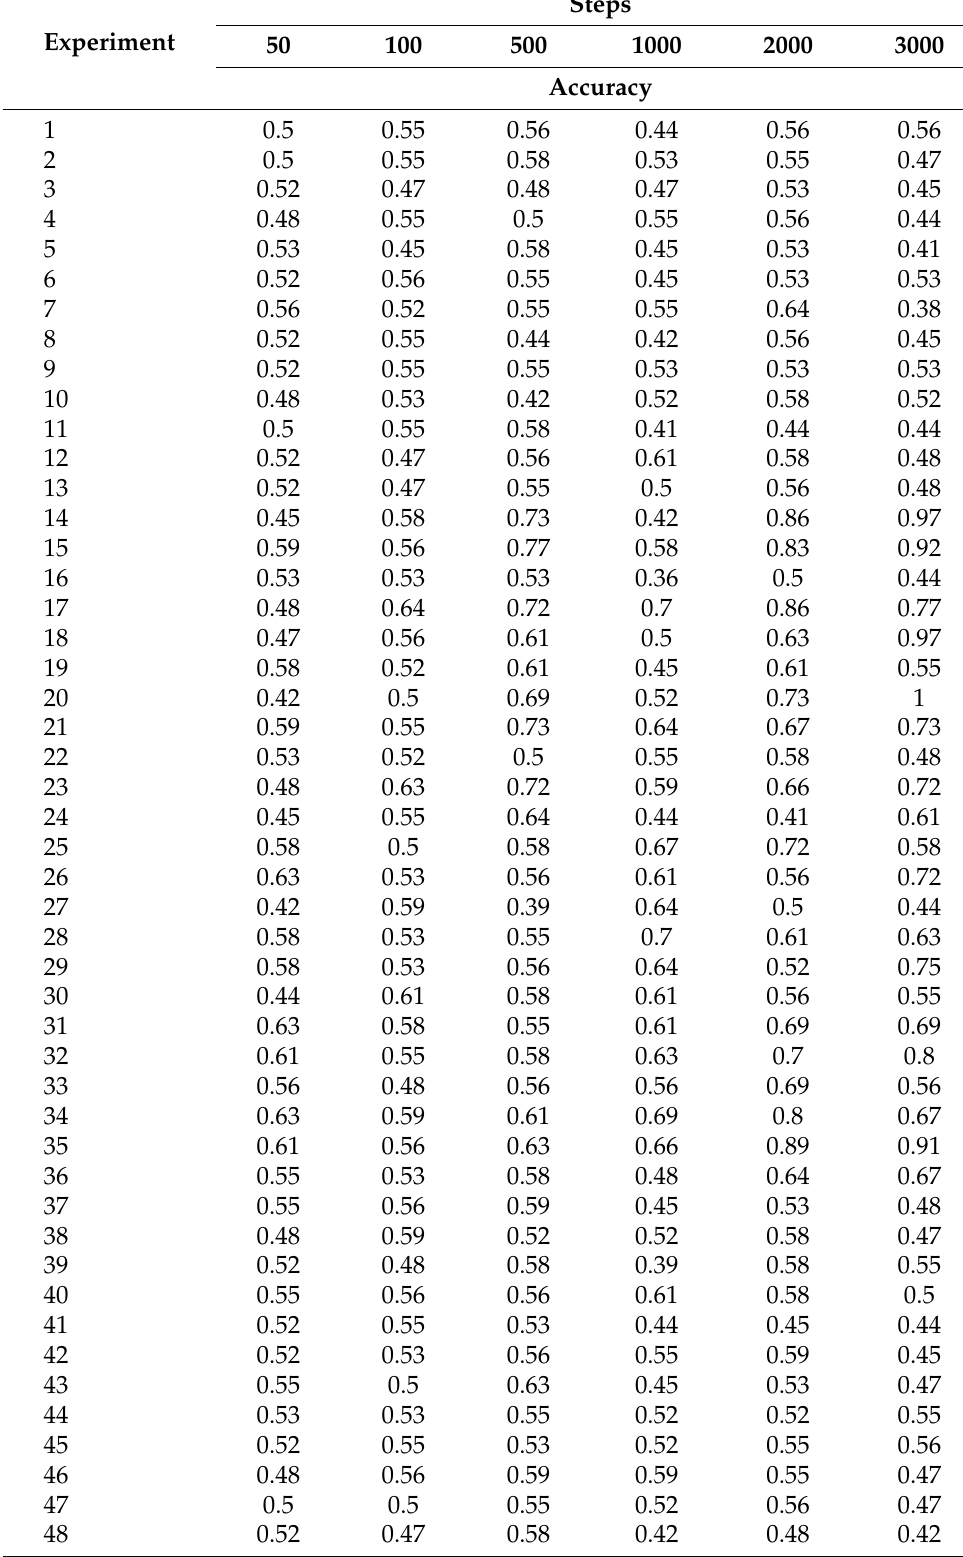
Table 6. Accuracy performance under the vehicle flow